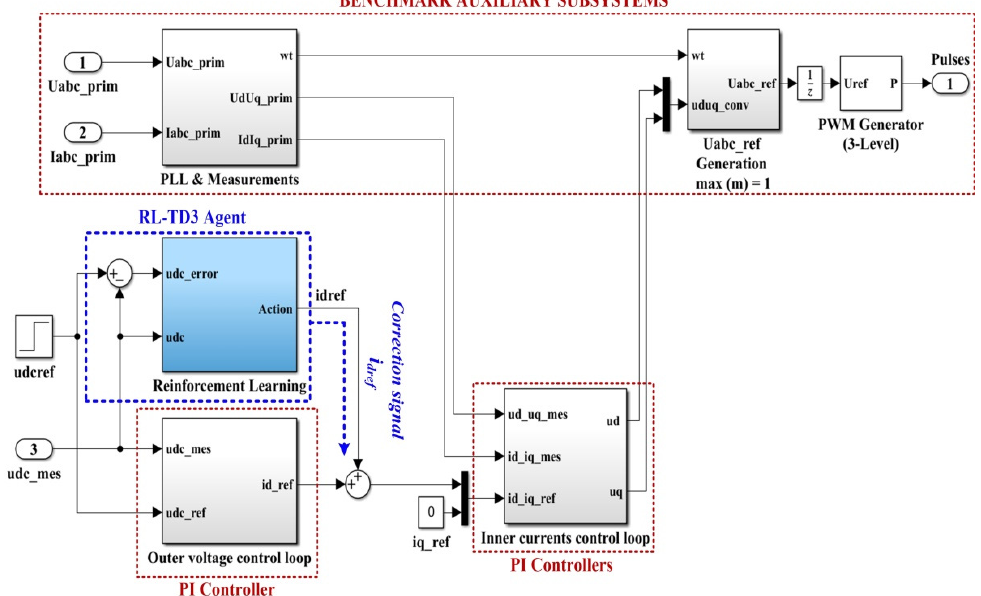
Figure 8. The model MATLAB Simulink implementation of the control system for the GC-PV array based on PI controllers using the RL-TD3 agent for the correction of the i dref command.